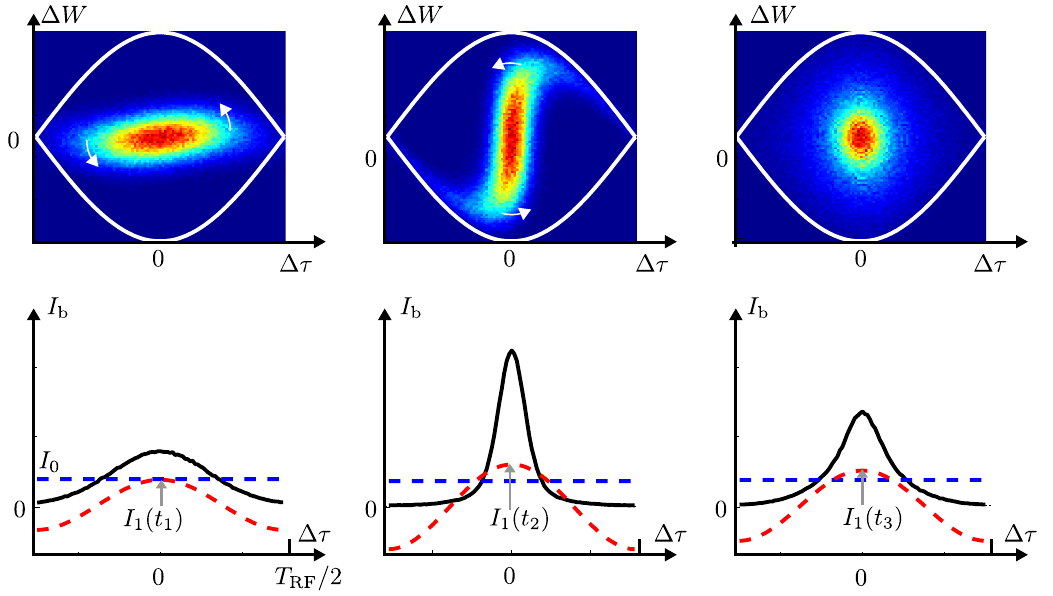
= 4 , and t ¼ T (cid:6) t , t in the longitudinal phase space. The 1 2 syn ; 0 3 2 as projection on (cid:1) (cid:2) (solid line) and the first two Fourier components with b